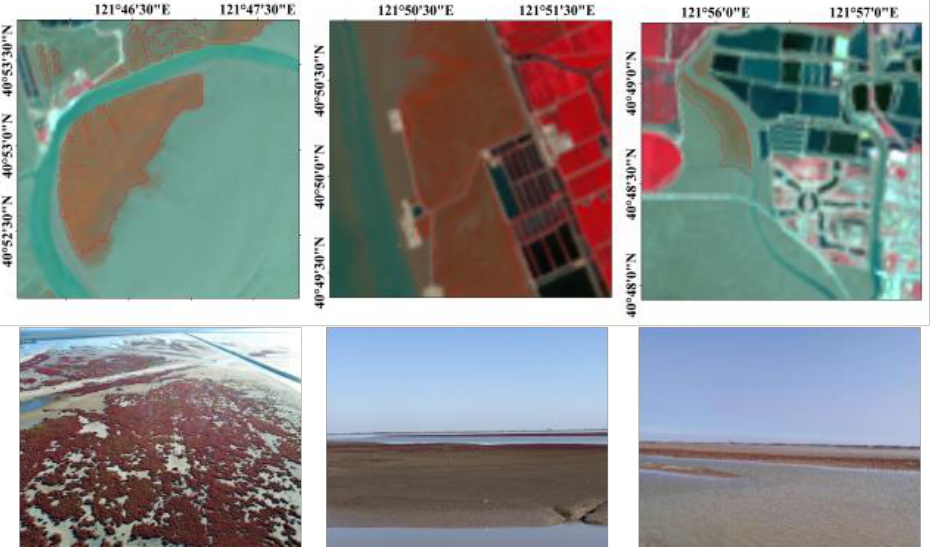
Figure 3. Locations of selected typical regions of interest of S. salsa.